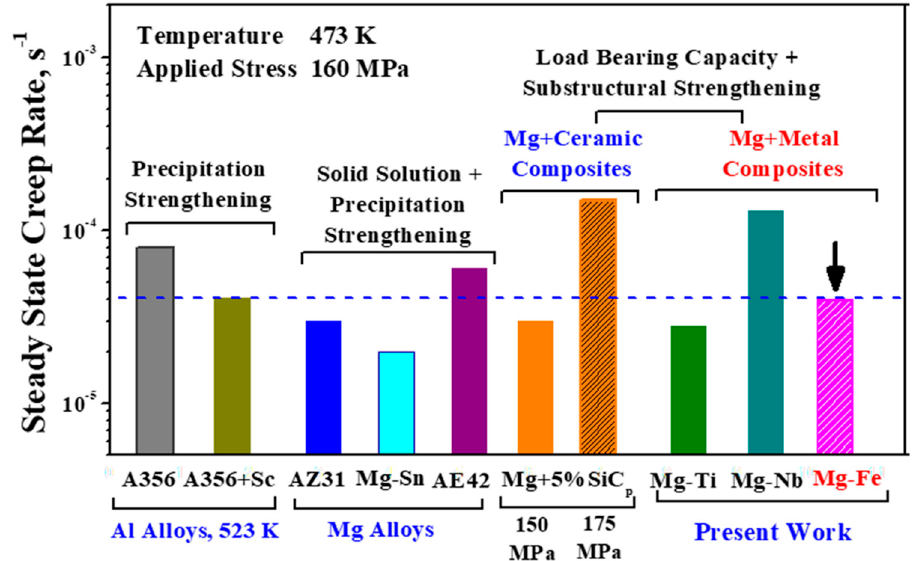
Figure 10. Steady state creep rate of Mg-5Fe (shown by arrow), Mg-5.6 Ti, Mg-5Nb, Mg alloys [27,48], Mg composites with ceramic reinforcements [49], and Al alloys [65]. Data for Mg alloys, Mg composites with ceramic reinforcements, and Al alloys were referred to from published reports. The data referred to for these materials are from impression creep tests conducted at the same temperature and stress as used in the present work (473 K; 160 MPa). Dominant creep strengthening mechanisms for the different material systems are